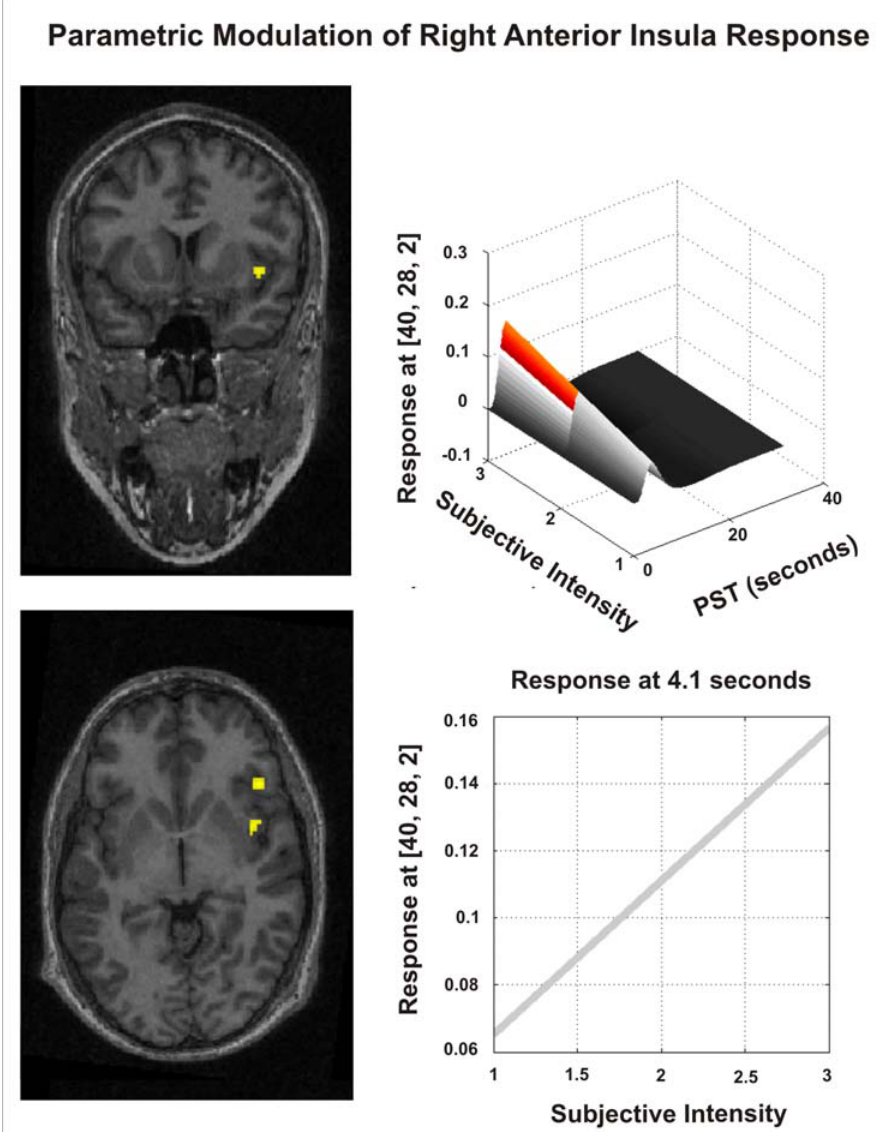
Figure 5. Right anterior insula and subjective ratings (within subject). Parametric modulation analysis of BOLD activity within right anterior insula by attributed intensity of neutral faces during false feedback were conducted within each subject. Second level group analysis of within subject results revealed a significant association within right anterior insula. Left: An individual subjects activation overlaid on their structural T1 weighted image. Right: Within the right anterior insula, the HRF amplitude is modulated as a function of the perceived intensity of neutral faces during false physiological feedback. The predicted response is illustrated across the entire HRF (right top) and at the peak HRF response (right bottom).